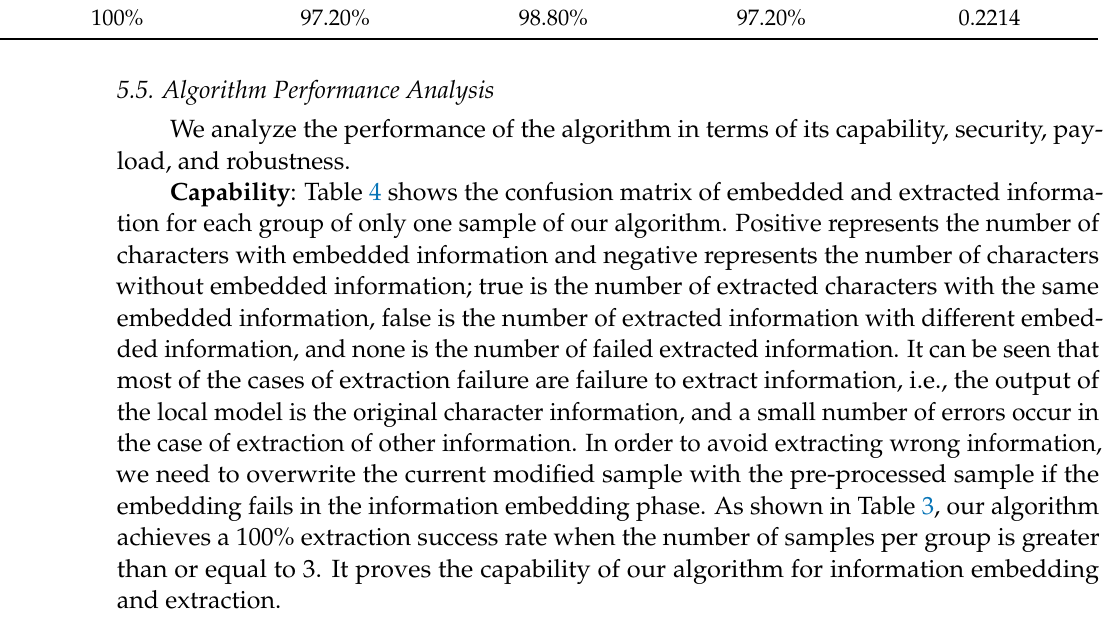
Table 4. Confusion matrix of embedded and extracted information when only one sample per